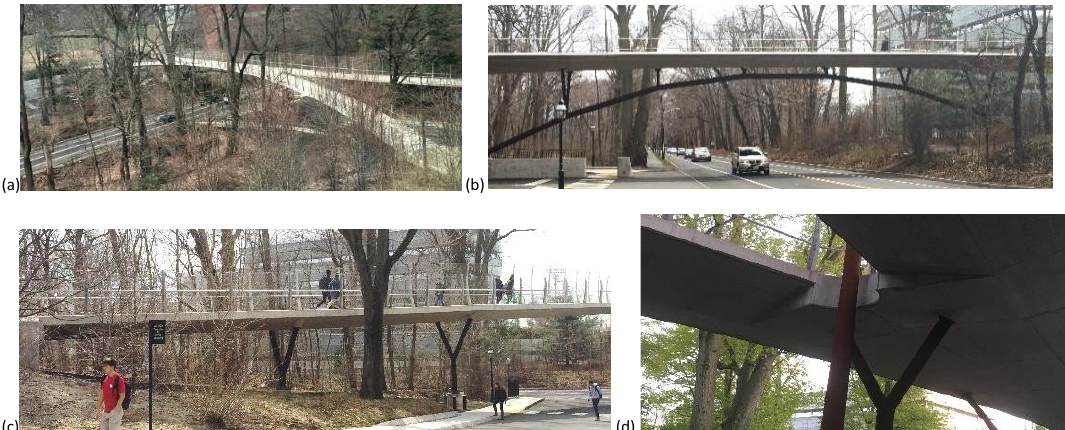
Figure 1. Streicker Bridge: ( a ) near-plan view: main span and approach legs, ( b ) main span: deck stiffened arch, ( c ) monitored SE leg: curved continuous girder, and ( d ) springing of main